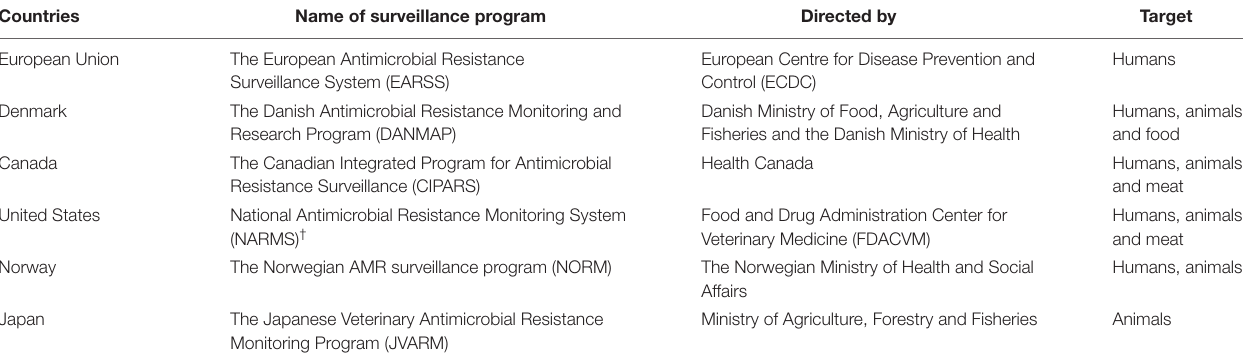
TABLE 6 | Examples of antimicrobial resistance monitoring and surveillance programs in some countries. Countries Name of surveillance